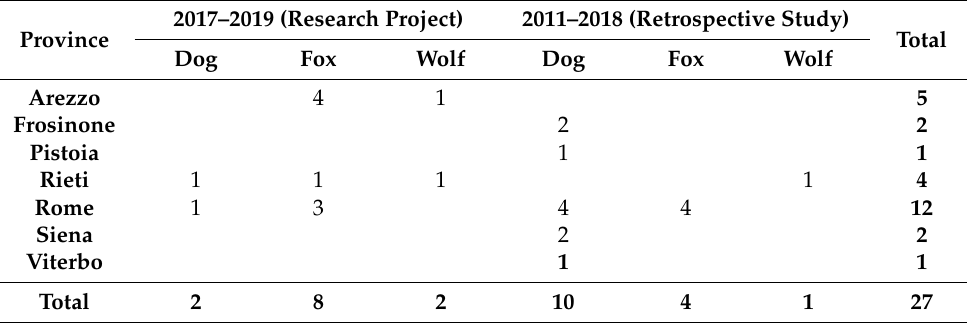
Table 2. Distribution of positive subjects by province and species